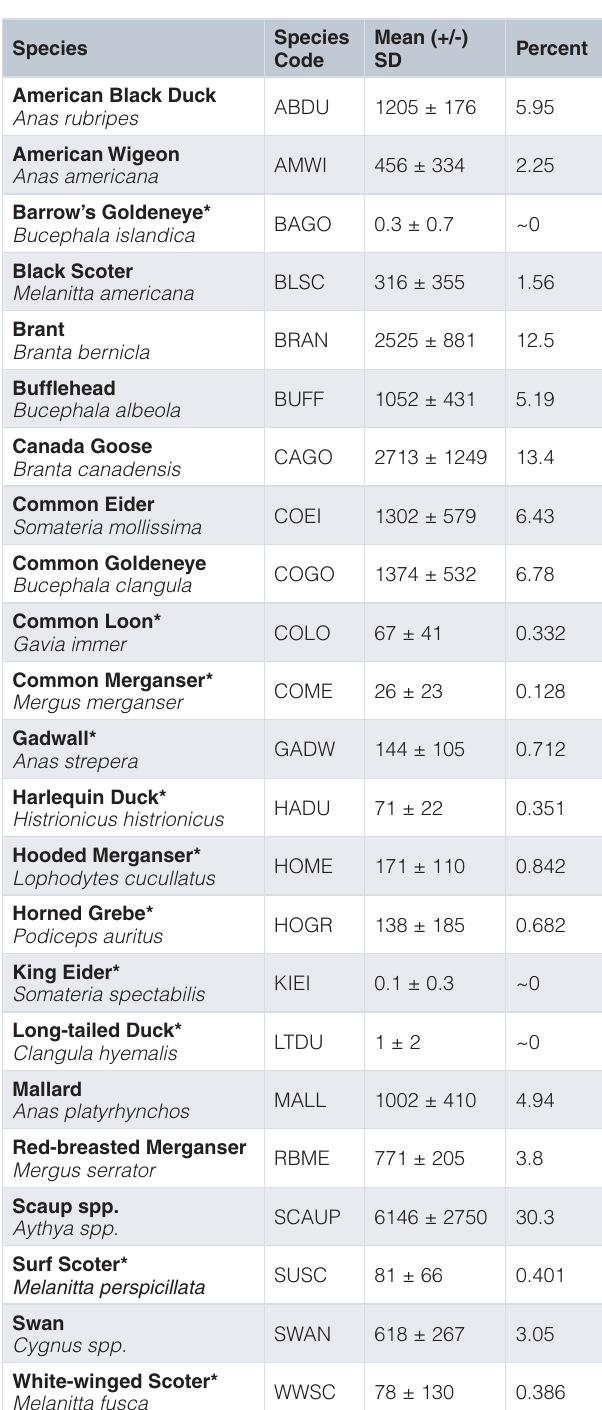
Table 2. Species summary of the Narragansett Bay Winter Waterfowl Survey for 2004–2011. Mean is the average abundance for each species throughout the entire study area. Percent represents the fraction that each species contributes to the total for duration of the